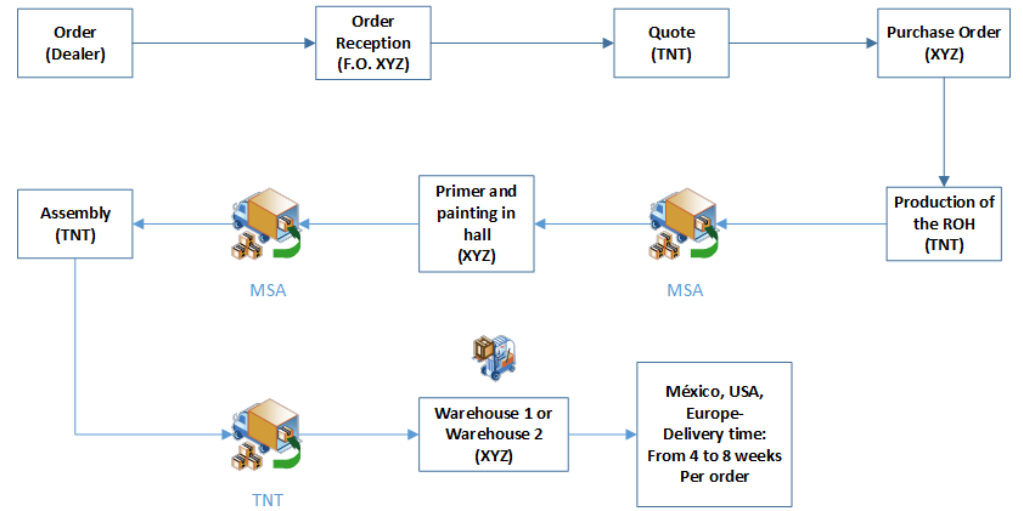
Figure 2. Flowchart of the process of the replacement part delivery.